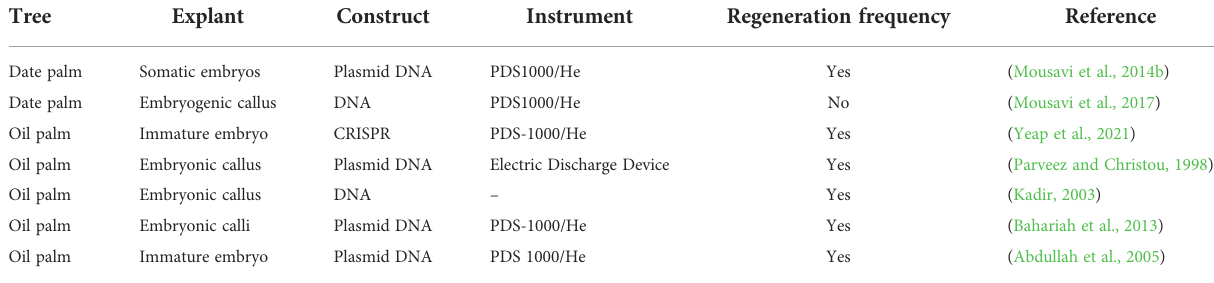
TABLE 3 Particle bombardment-mediated transformation in palm